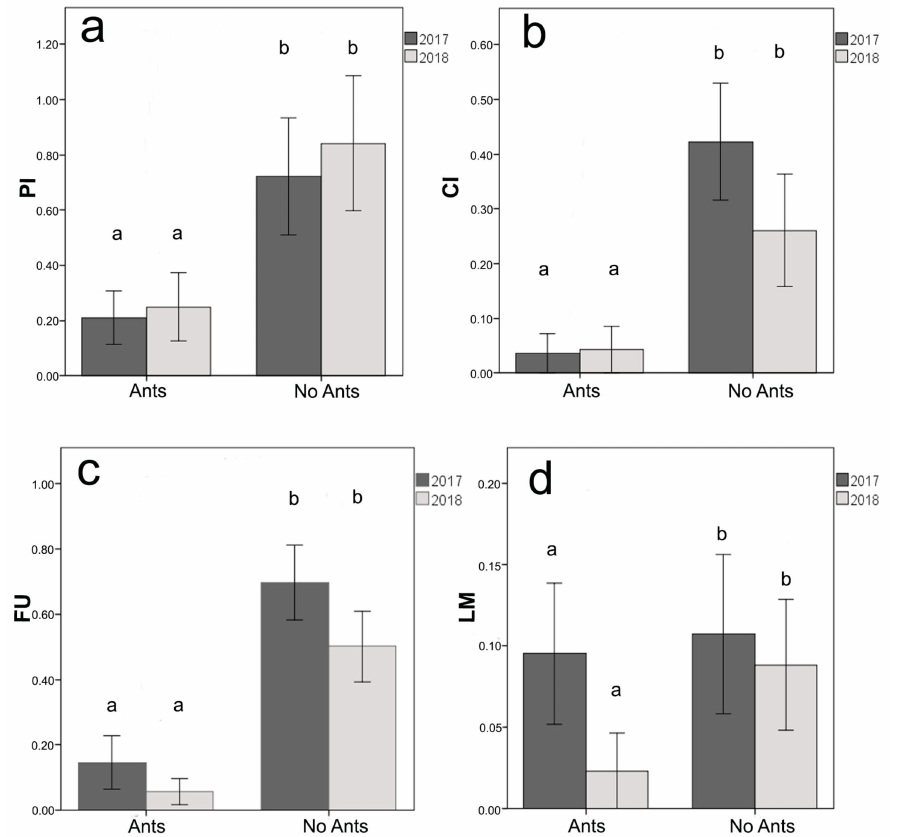
Figure 9. E ff ects of the ant presence on plant health. The e ff ects are shown according to the two years of sampling (2017–2018). ( a ) PI: mean number of Phytophagous Insects, ( b ) CI: mean proportion of leaves attacked by chewing insects on the total leaves, ( c ) FU: mean proportion of leaves attacked by Fungi on the total leaves, ( d ) LM: mean proportion of leaves attacked by leaf miners on the total leaves. The SE interval is shown for each bar. The bars with the same letter are not statistically di ff erent (Two-way ANOVA, see text for further